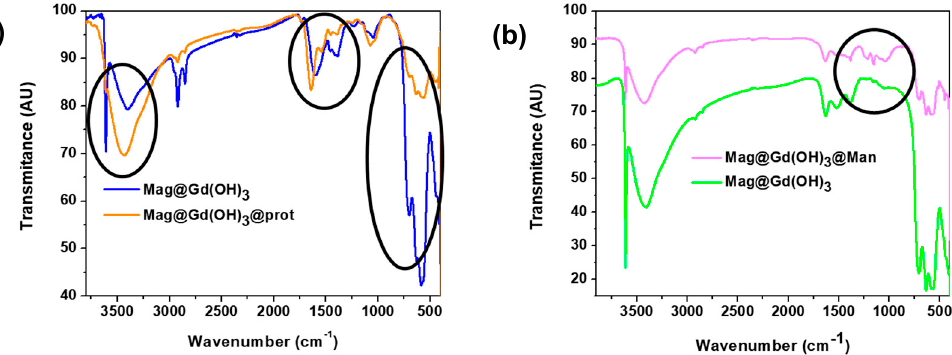
Figure 9. ( a ) Comparison between FTIR of ( a ) Mag@Gd(OH) 3 before and after protein adsorption. ( b ) Mannose-coated and uncoated hybrid nanoparticles. In both cases, the areas of interest are marked.